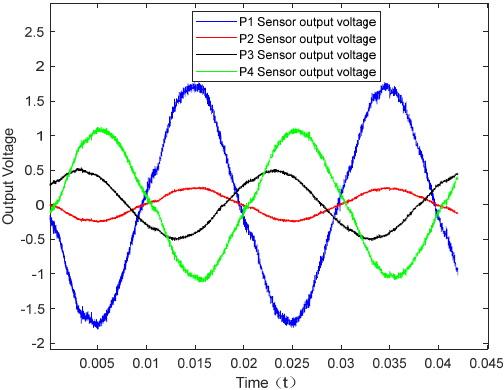
Figure 14. Magnetic sensor output voltage waveform.